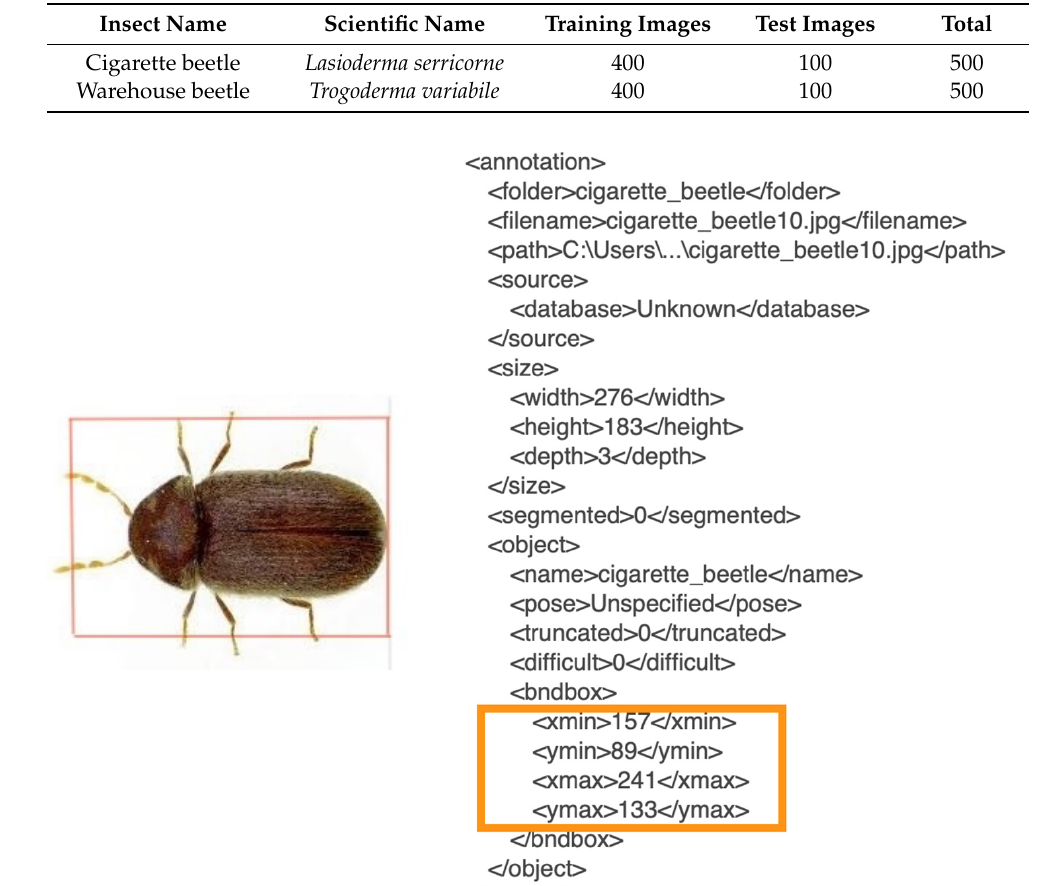
Table 1. Partition of images per insect.